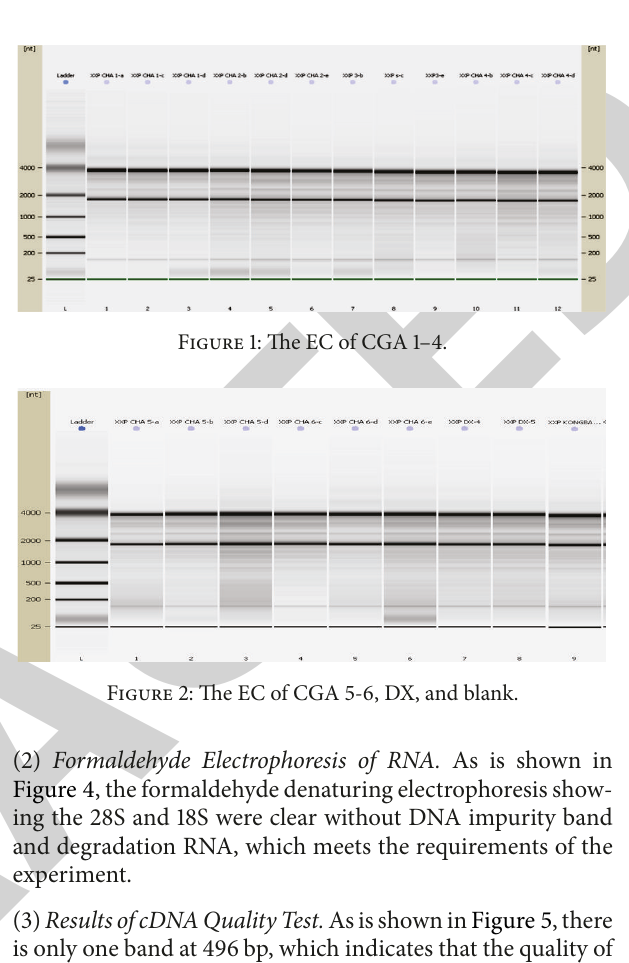
Table 2: The reaction system of q-PCR ( 𝑛 = 3 ).